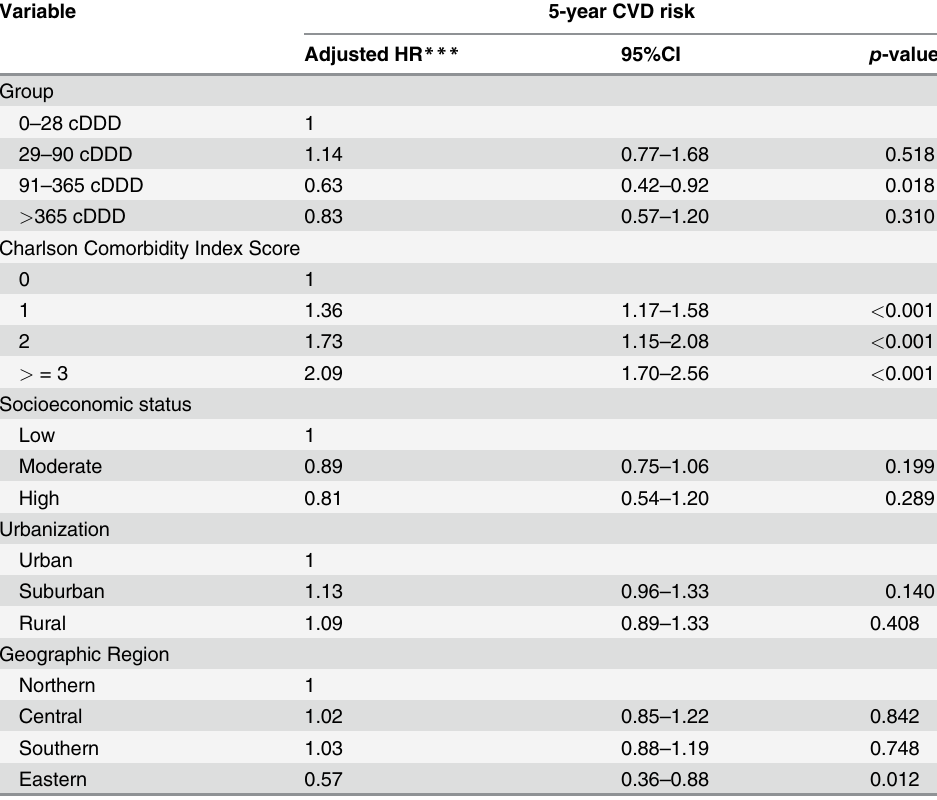
Table 4. Multivariate adjusted hazard ratios (HR) of cardiovascular diseases (CVD) among older (65 years old or older) patients receiving and not receiving 5-alpha reductase inhibitors from 2003 to